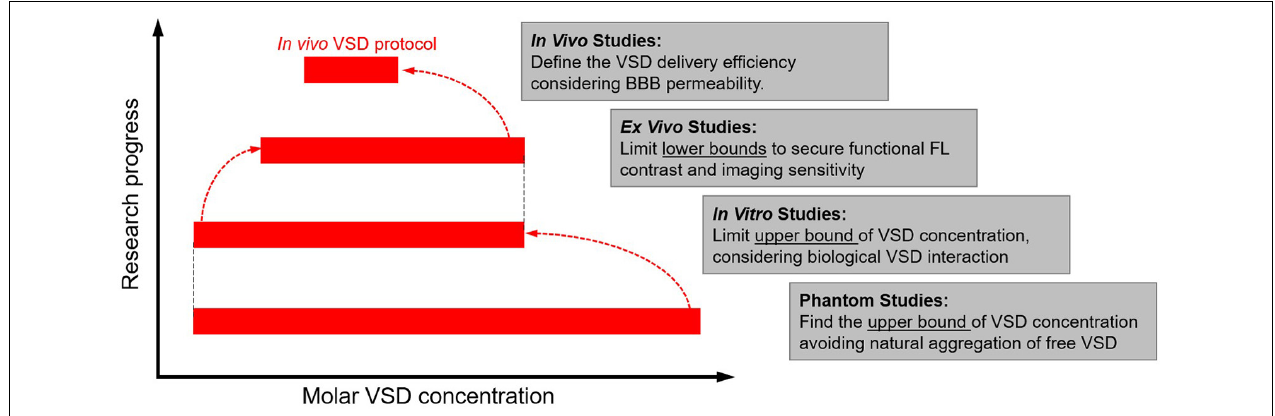
FIGURE 2 | Experimental design flow chart to establish target VSD tissue concentrations that maximize fluorescence percentage change observable due to neuronal depolarization in rodents.